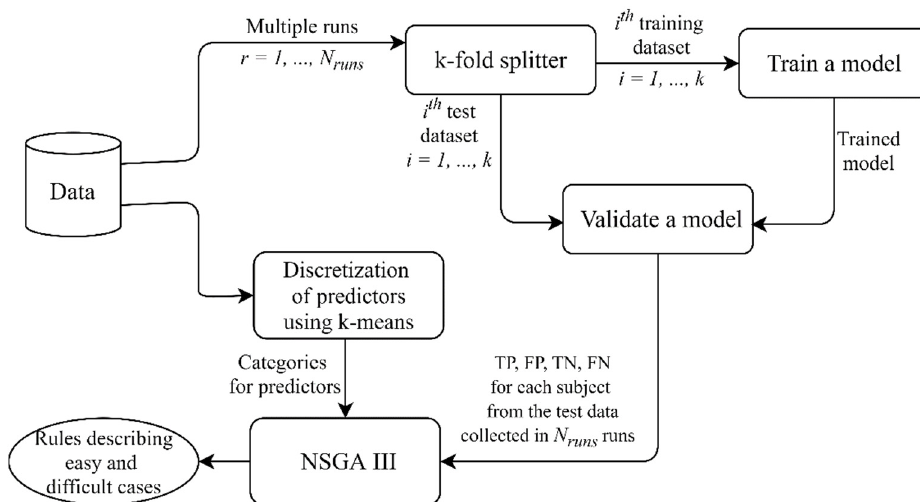
Figure 3. The pipeline implemented in this study. In several independent runs of cross-validation, the model performance was estimated using the test data and the results were collected for further analysis. Discretization was applied to continuous predictors to define their levels (categories) used for generating rules. NSGA III found combinations of predictors and their values describing “easy” cases, i.e., subgroups of subjects with a large number of true positive (TP) and true negative (TN) predictions, and “difficult” cases, i.e., subgroups of subjects with a large number of false positive (FP) and false negative (FN) predictions.